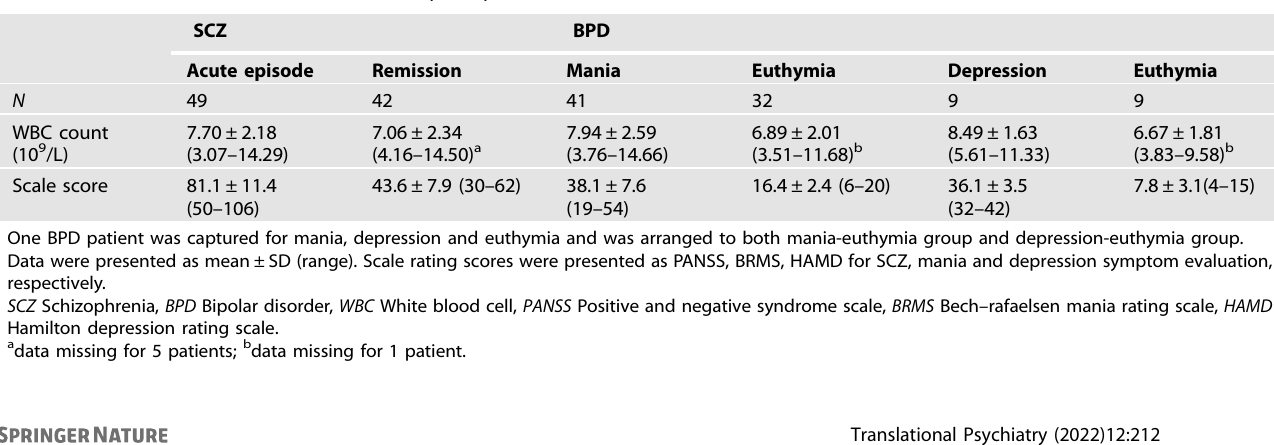
Table 2. Clinical characteristics of SCZ and BPD